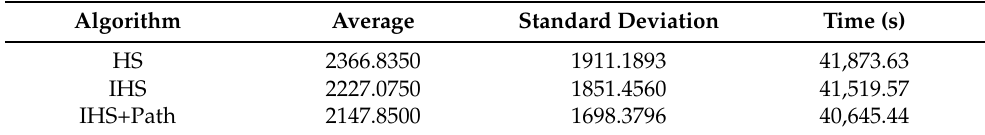
Table 5. Convergence analysis results for the 119-bus test